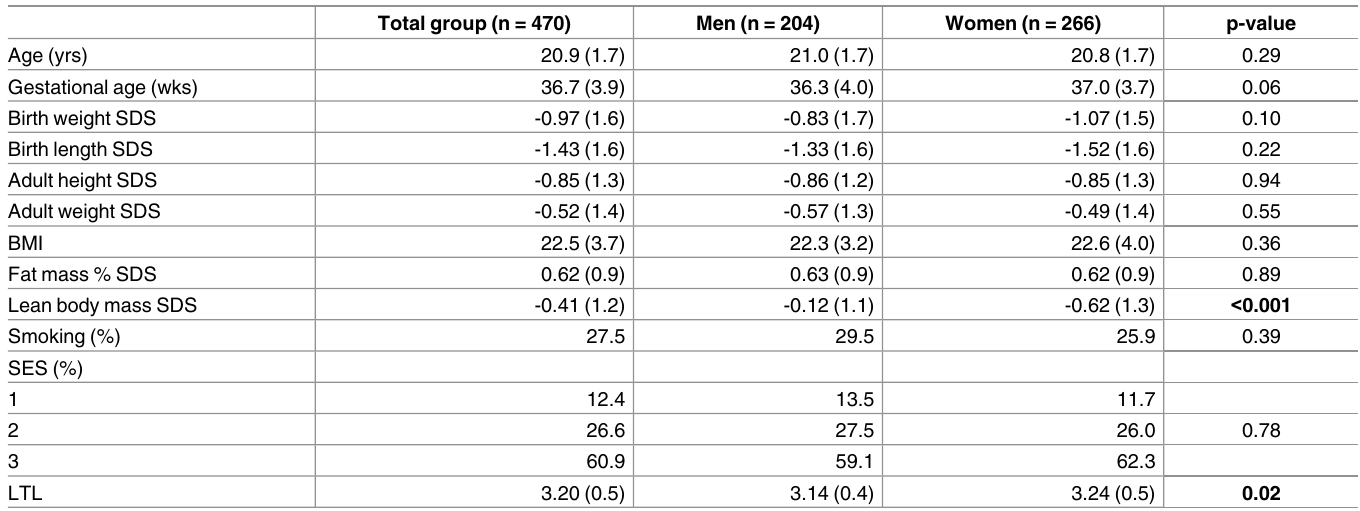
Table 1. Clinical characteristics.